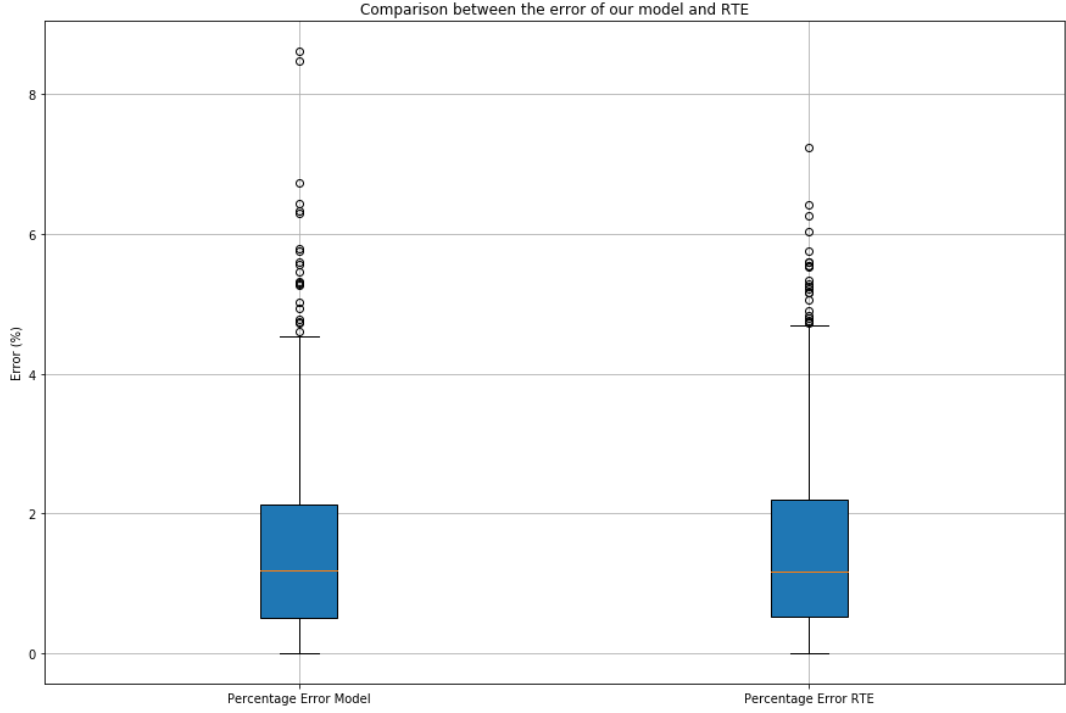
Figure 8. Absolute percentage error distribution provided by the deep learning structure proposed in this paper and the RTE subscription-based service.